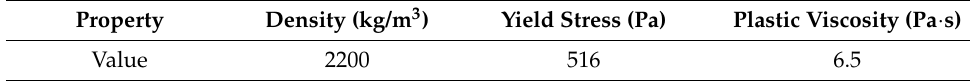
Table 1. Material properties measured and used in simulations.